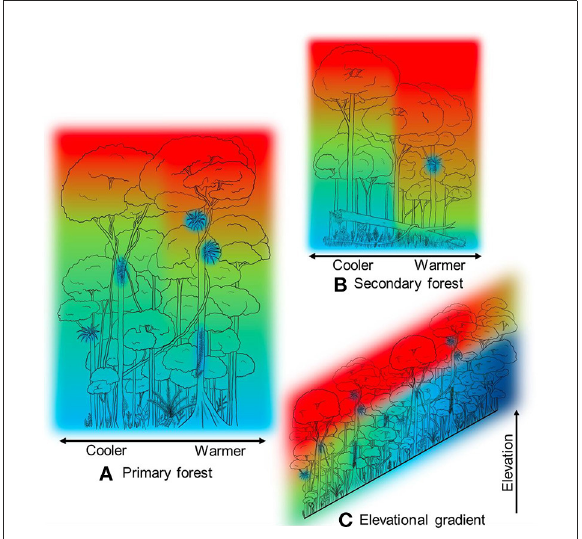
FIGURE1 Hypothetical depictions of how vertical stratification created by forest canopies interact with anthropogenic disturbance and elevational patterns across time. Colors represent differences in microclimatic conditions (i.e., average and variability of temperature and humidity) and corresponding changes in biodiversity and ecosystem functions. In a primary forest (A) , canopies intercept a large amount of insolation, providing cool and stable microclimates in the understory. In addition, epiphytes in the canopy strata create and maintain cool and wet microhabitats. In a secondary forest (B) , the magnitude of thermal buffering is smaller than in primary forests due to more exposed canopy surfaces, creating hotter and more unstable conditions in the understory (Sagar and Devy). In addition, seasonal variations may be intensified in the secondary forest. Along an elevational gradient (C) , highly variable climatic conditions in the canopy may cause organisms to have greater elevational range distributions (analogous to Rapoport’s rule), making elevational species’ turnover smaller in the canopy than the understory (Leahy et al.,